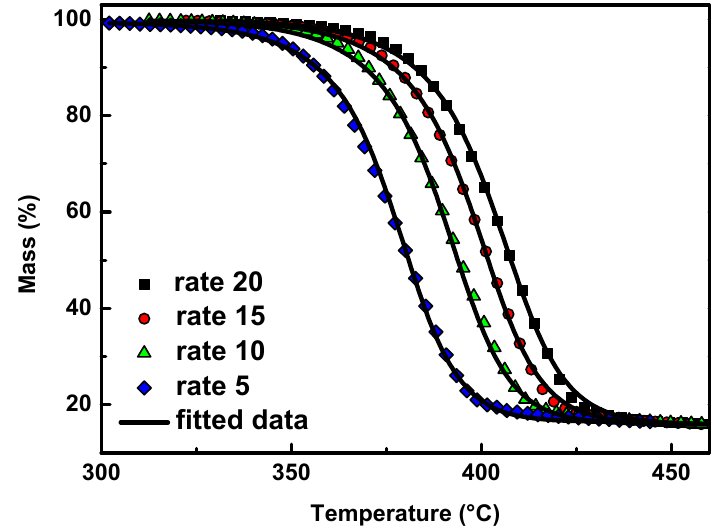
Figure 7. Mass (%) curves of PPF / 2.5 GNP nanocomposite at heating rates of 5, 10, 15, and 20 ◦ C / min in a nitrogen atmosphere (symbols) and the corresponding fitting curves with the Cn model (continuous black lines). Table 2. Activation energy, pre-exponential factor and reaction order of neat PPF and PPF / 2.5 GNP